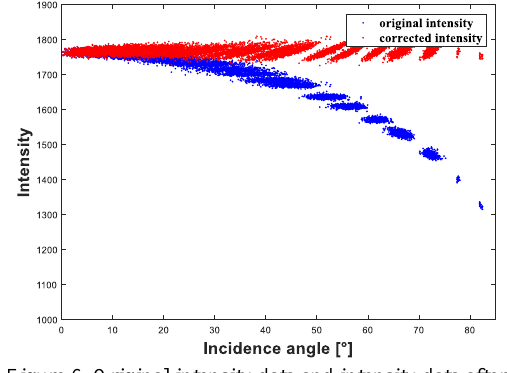
Figure 6. Original intensity data and intensity data after incidence angle effect correction